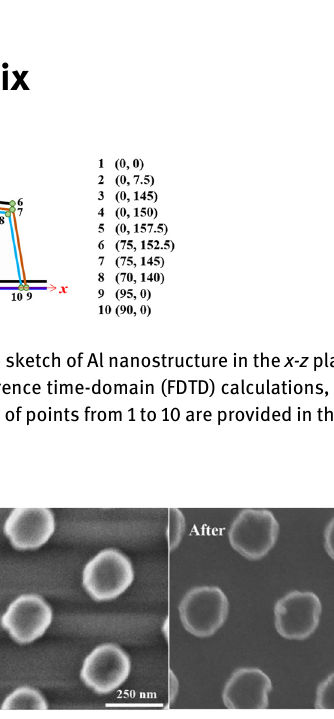
Figure S2: The scanning electron microscopy (SEM) image of Al nanoparticle (NP)array with a = 400nm before(left) andafter(right) deposition of 7.5 nm Fe fi lm on the